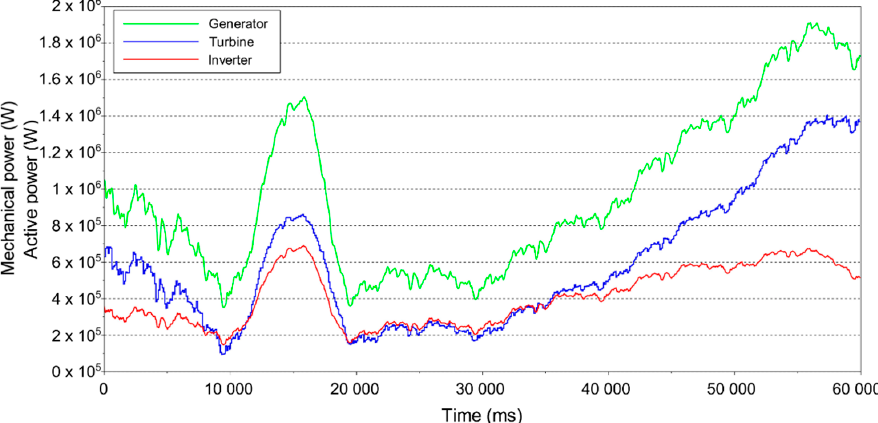
Figure 13. Generated power by wind speed variations.